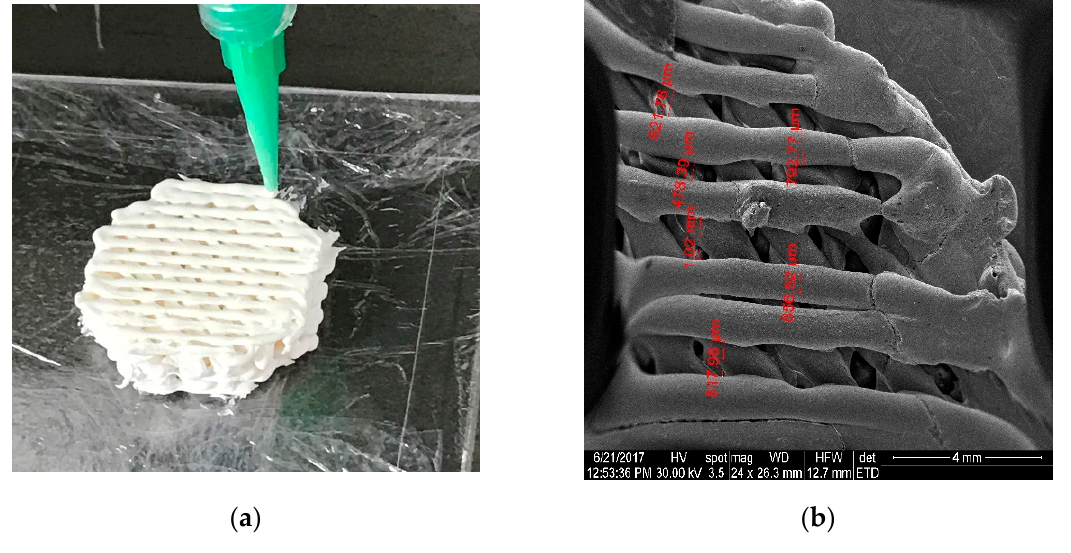
Figure 3. Hydroxyapatite scaffolds for bone tissue engineering made by 3D printing: ( a ) Macroscopic view; ( b ) Detailed view of the interconnecting channel structure with diameter of about 800 µm.